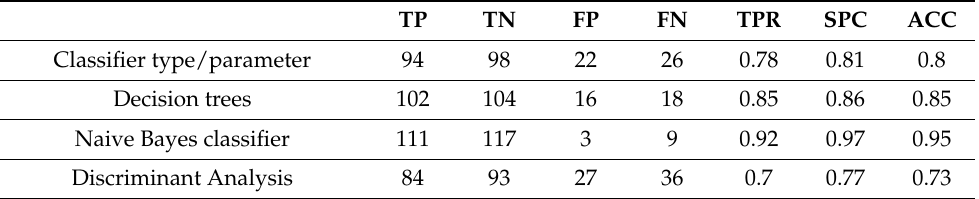
Table 1. Results obtained for 120 healthy patients and 120 treated patients. The measurements of